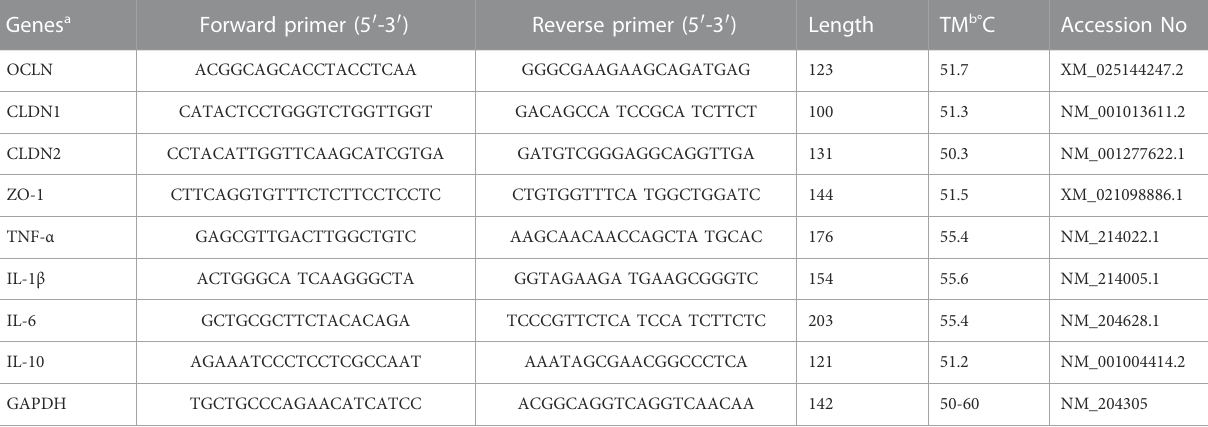
TABLE 2 Primer sequences of target genes.